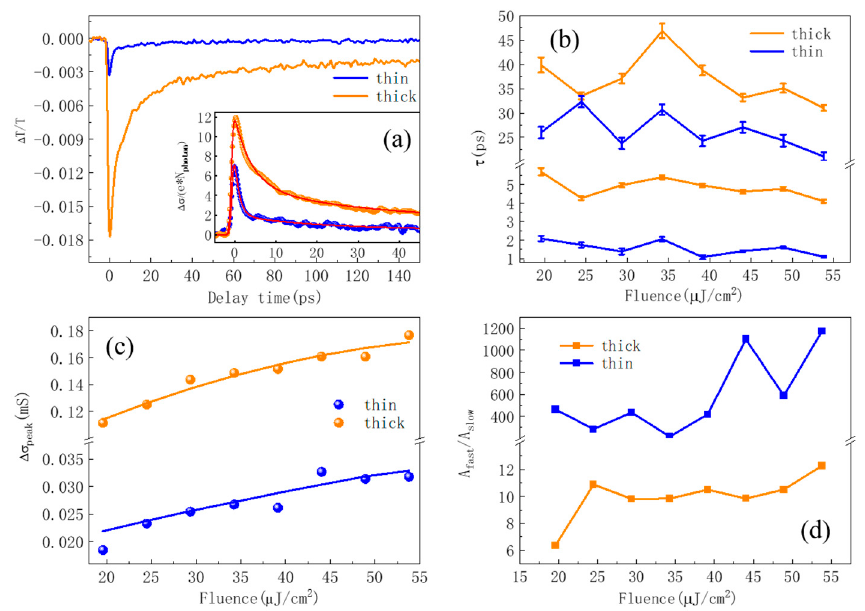
Figure 3. ( a ) Typical dynamic THz transmission of both thick and thin SnS 2 nanoflakes, the inset plots the two transient THz PC together under the same absorbed photons density. ( b ) The fitting time constants ( τ fast and τ slow ) with respect to pump fluence at 400 nm for both thin and thick SnS 2 films. ( c ) The maximum THz PC with respect to pump fluence for both thin (blue) and thick (yellow) SnS 2 films. ( d ) The amplitude ratio, i.e., A fast /A slow with respect to pump fluence for both thin (blue) and thick (yellow) films.